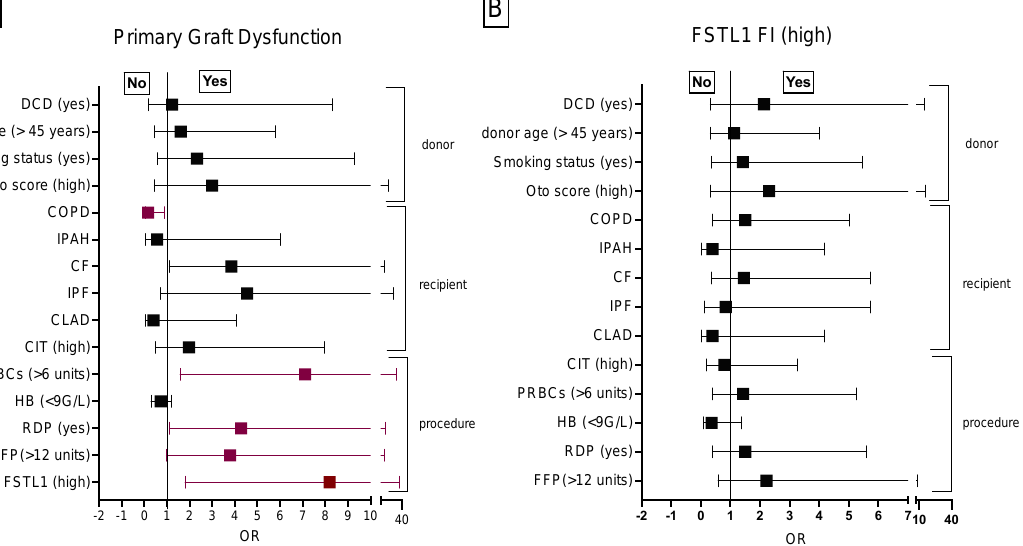
Figure 4. Association between procedure-, recipient- and donor-related risk factors to PGD ( A ) and high FSTL1 FI ( B ). The odds ratio was calculated for donor-, recipient- and procedure-related factors. The cut-off value for FSTL1 RI was set at 10.2. COPD, chronic obstructive pulmonary disease; DCD, donation after circulatory death; FFP, fresh frozen plasma; FSTL1, follistatin-like 1; HB, hemoglobin minimum; PRBCs, packed red blood cells; RDP, random donor platelets, RI relative in- crease.